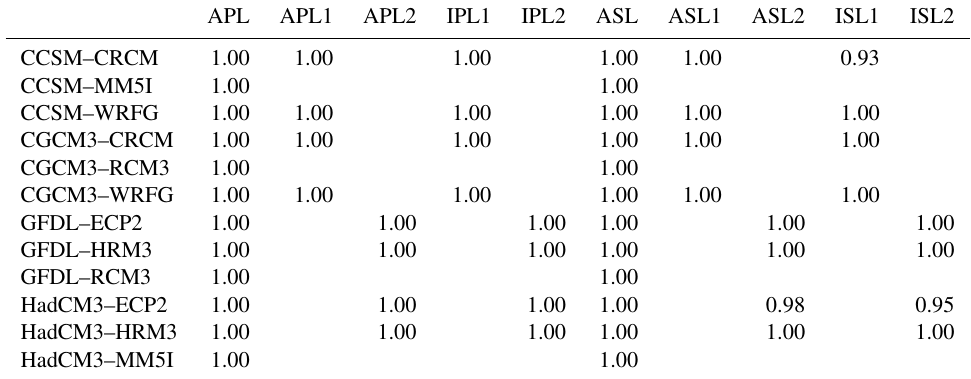
Table 4. The proportion of estimated null hypotheses in the Ljung–Box test of independence for the transformed